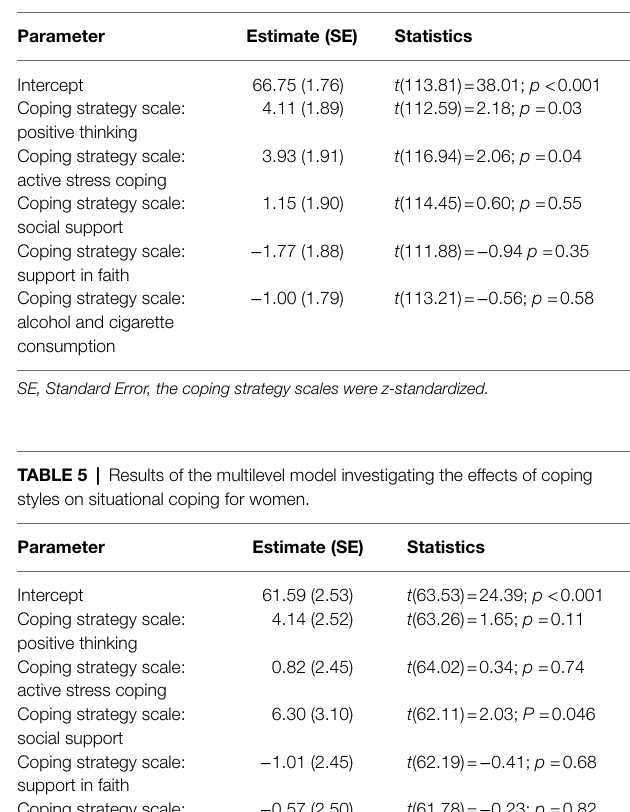
TABLE 4 | Results of the multilevel model investigating the effects of coping styles on situational coping in the total sample.